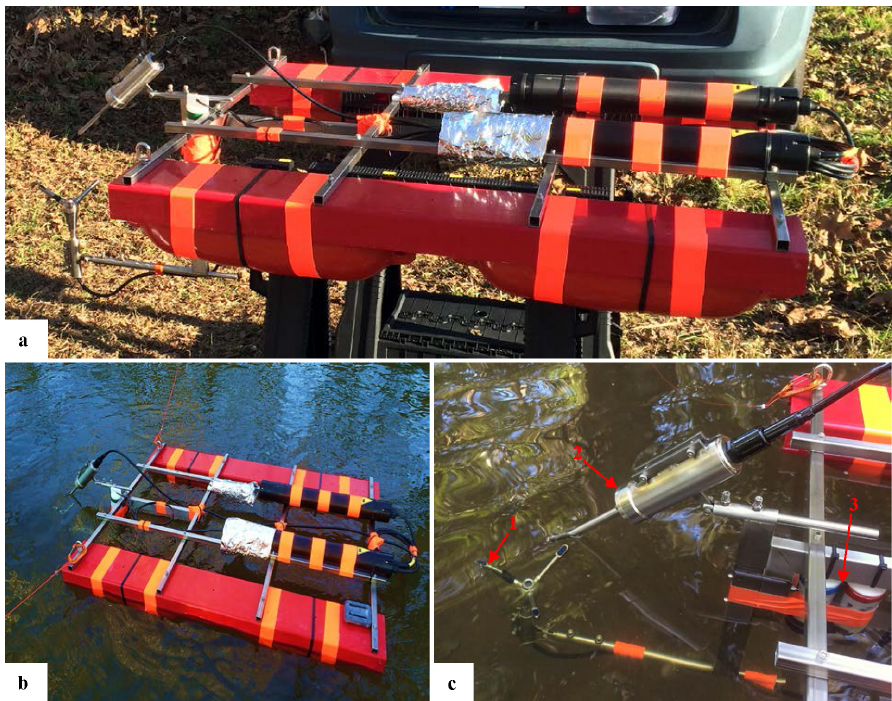
Figure 1. Floating platform for determining air–water gas exchange. (a) The 1.2m × 0.9m wide platform with a catamaran-shaped hull being prepared for deployment. Four inflatable fenders provide flotation. (b) The platform deployed in the Hardware River and anchored to both river banks. A dive weight is used to level the platform. (c) Close-up look at: (1) the three-pronged upward-facing sensor head of the cabled acoustic Doppler velocimeter (cabled Vector, Nortek AS, Norway), (2) the fast-responding dual O 2 –temperature sensor (RINKO EC, JFE Advantech, Japan), and (3) two stable independent dual O 2 –temperature sensors used for calibration (miniDOT, PME,